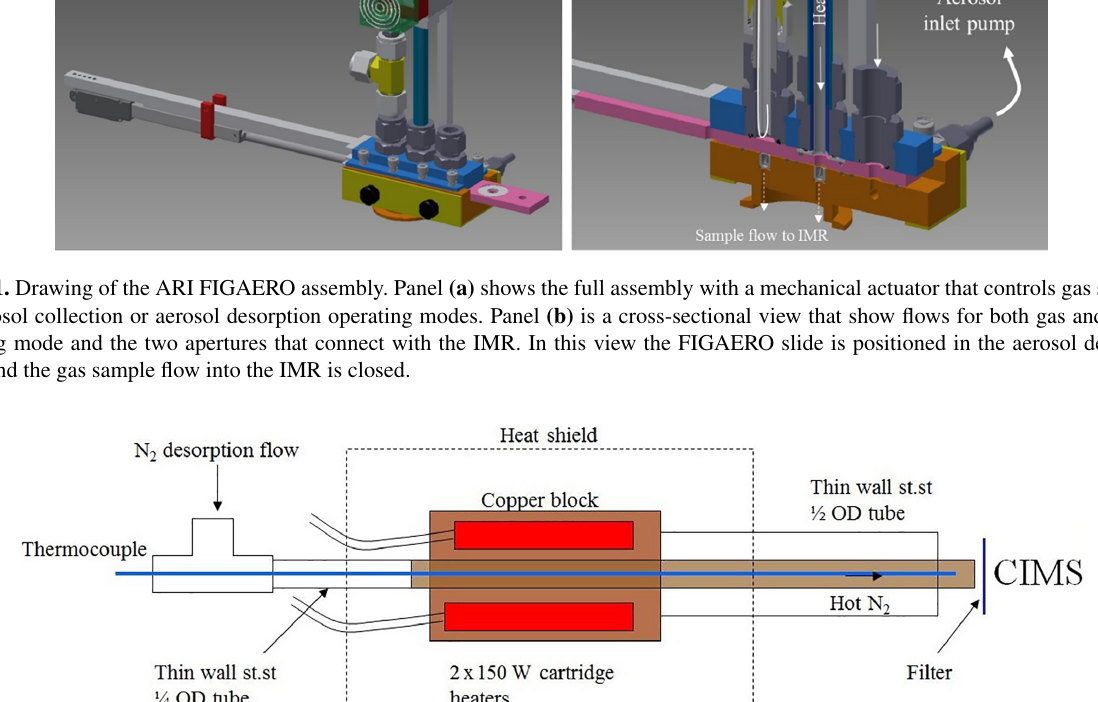
phase changes independently as a function of